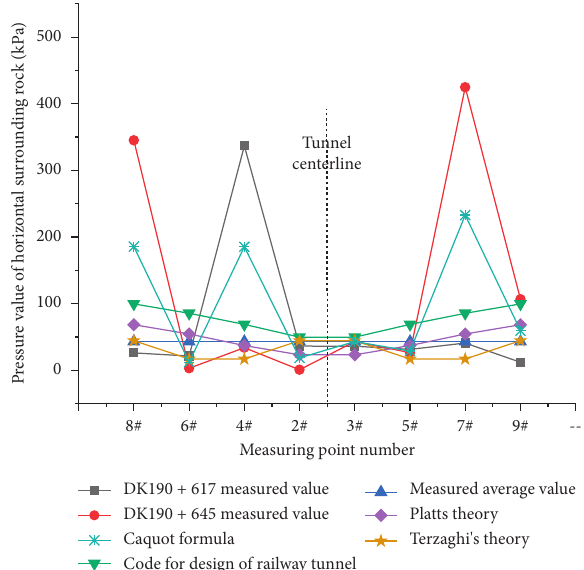
Figure 10: Pressure distribution of horizontal surrounding rock at each measuring point.